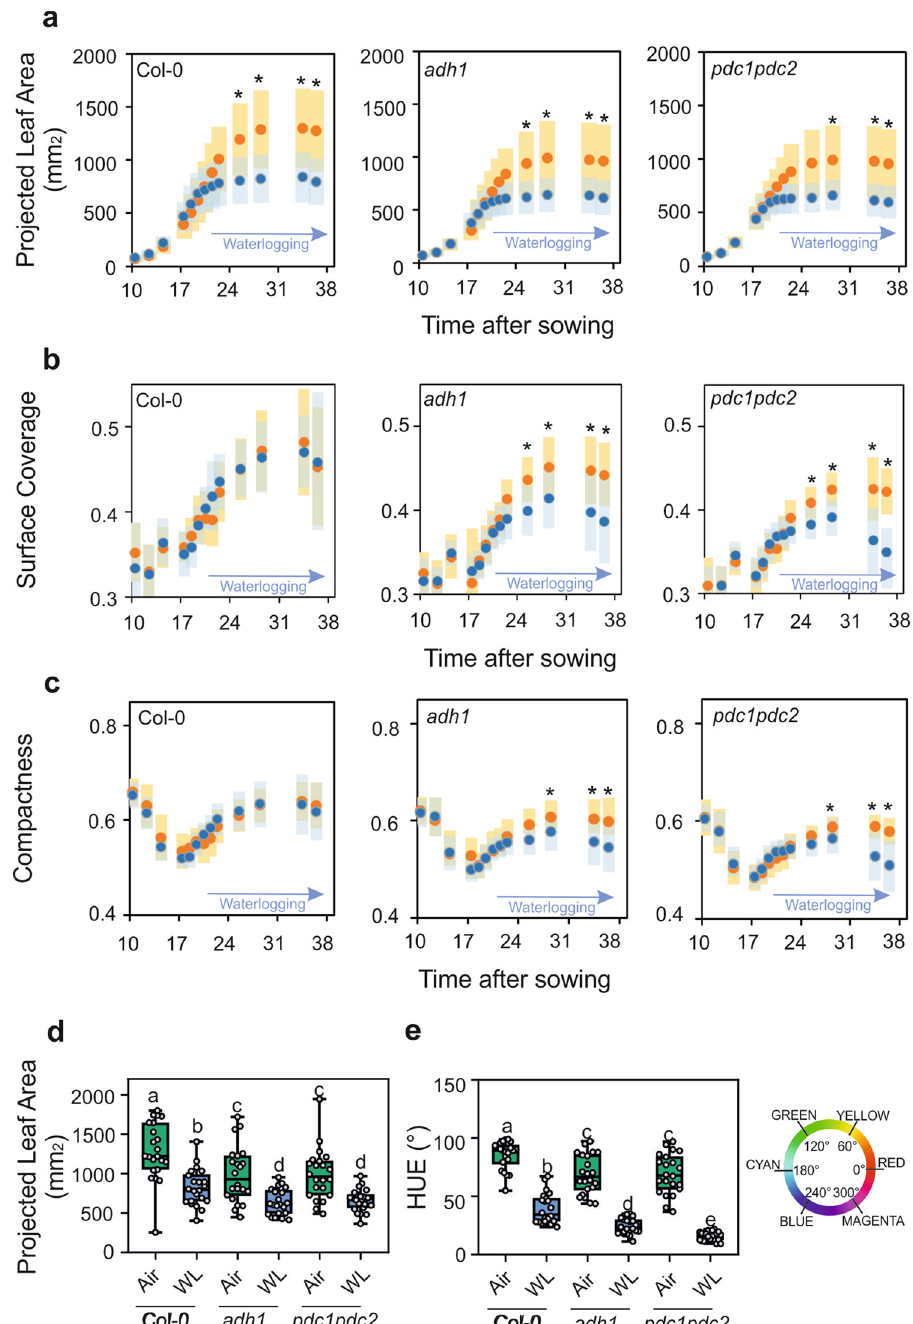
Figure 4. Plant size ( a ) and morphology traits ( b, c ) plotted against time in aerobic plants (orange symbols) compared to plants that were waterlogged (blue symbols). Variance (± SD, n = 22) is shown as color-shaded areas (yellow: aerobic; light blue: waterlogging). Statistically significant differences are indicated by an asterisk ( T test, pairwise comparison at each time point, * = p < 0.01). ( d ) Plant size (projected leaf area) in aerobic plants (green box) compared to plants that were waterlogged (blue box). Data were taken at day 28. ( e ) Color (HUE-value from HSI color space) in aerobic plants (green box) compared to plants that were waterlogged (blue box). The color wheel gives values for HUE ranging from 0 to 360°. Data were taken at day 28. Lines in the boxes indicate the median. The bottom and top of each box denote the first and third quartile, respectively. The dots represent the single data points and whiskers denote the min/max values. Different letters indicate statistically significant differences